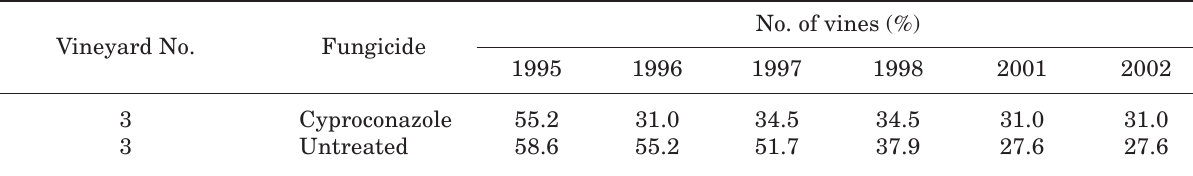
Table 9. Vines treated with ground applications of fungicide and grouped by vigour level. Vineyard No.